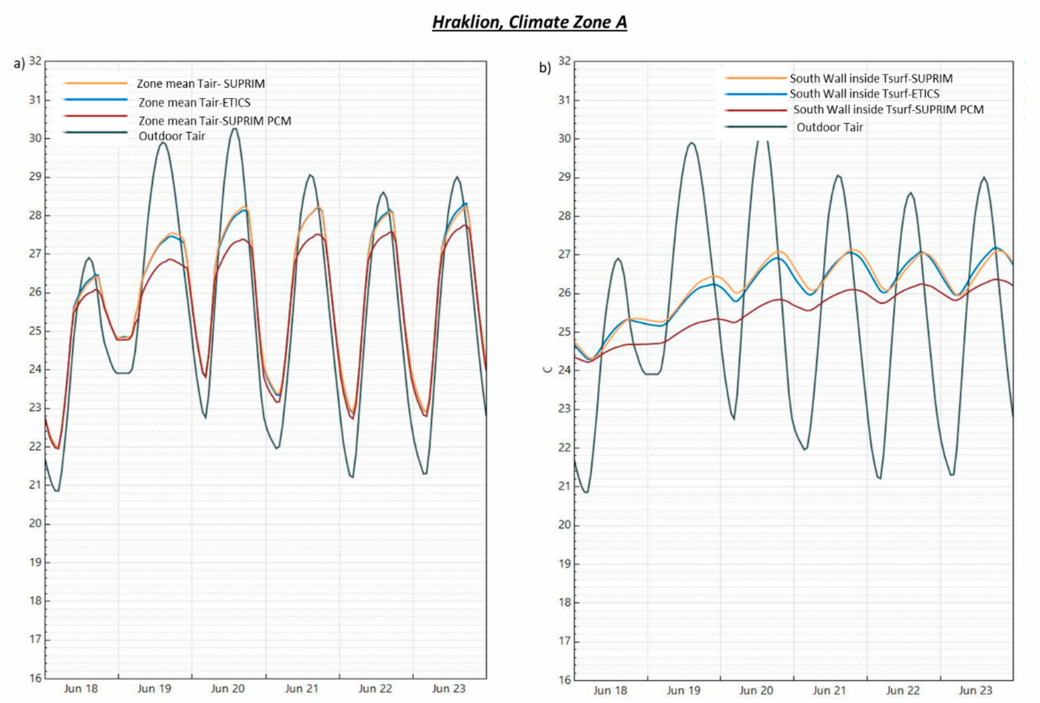
Figure 8. Climate zone A: ( a ) outdoor Tair and indoor Tair and ( b ) outdoor Tair and Tsurf evolution of the south facing wall during a typical week in June for the three investigated wall configurations and for 10 cm external insulation.